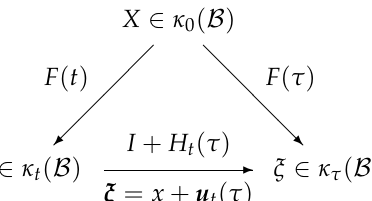
Figure 1. The deformation and deformation gradient